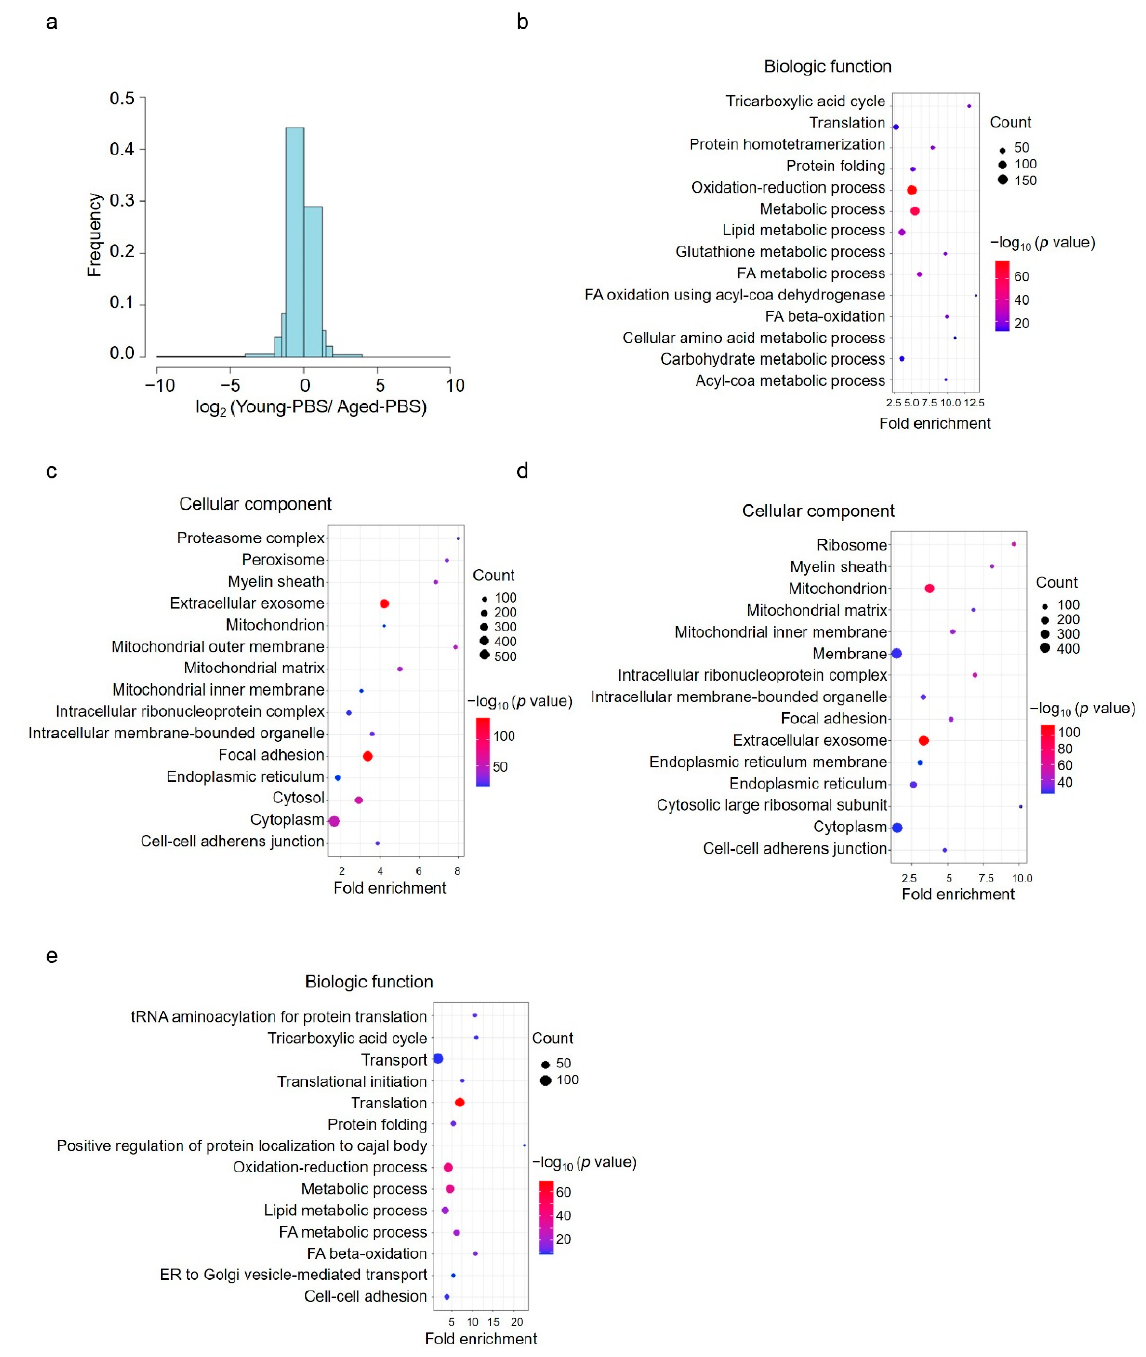
Figure 3. Analysis of acetylome in young and aged mice. ( a ) Frequency distribution showed more acetylated peptides were identified in aged mice than those in young mice. x axis was blocked at − 10, − 4, − 2, − 1.5, − 1.25, 0, 1.25, 1.5, 2, 4, 10. ( b ) Biological function analysis of 997 acetylated proteins with increased acetylation in aged livers compared with young livers. ( c ) Cellular component distribution of 997 acetylated proteins with increased acetylation in aged livers compared with young livers. ( d ) Cellular component analysis of 845 acetylated proteins with reduced acetylation in aged livers compared with young livers. ( e ) Biological function analysis of 845 acetylated proteins with reduced acetylation in aged livers compared with young livers. Young-PBS: young mice treated with PBS, Aged-PBS: aged mice treated with PBS, Aged-NMN: aged mice treated with